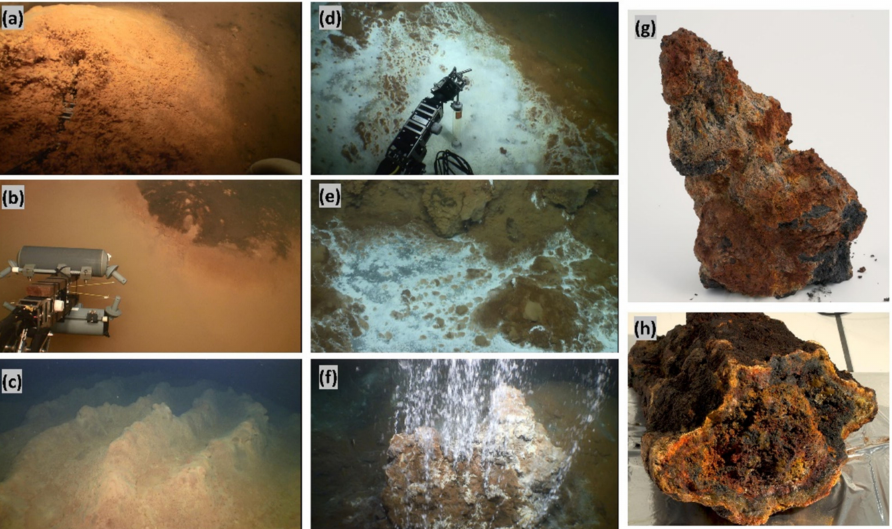
Figure 2. Photos of the samples used in metagenomics: ( a ) RED1; ( b ) RED2; ( c ) RED3; ( d ) WH1; ( e ) WH2; ( f ) WAT1; ( g ) CH1; ( h ) CH2. Underwater photos were taken by the cameras attached to the frame of the Remoted Operated Vehicle MaxRover of HCMR that was used for samples